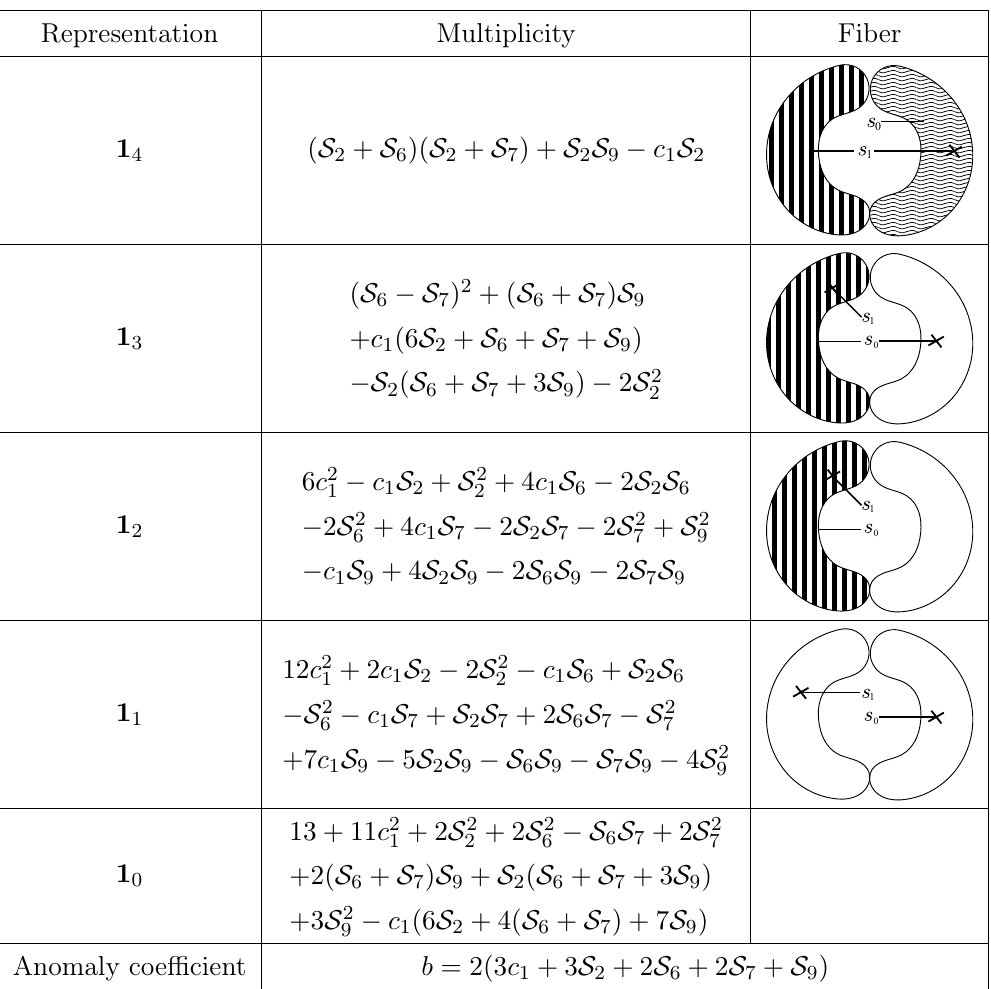
Table 5 . Summary of the charged matter representations and multiplicities under U(1) and codi- mension two fibers of nef (5 ; 1) and its anomaly coefficient.